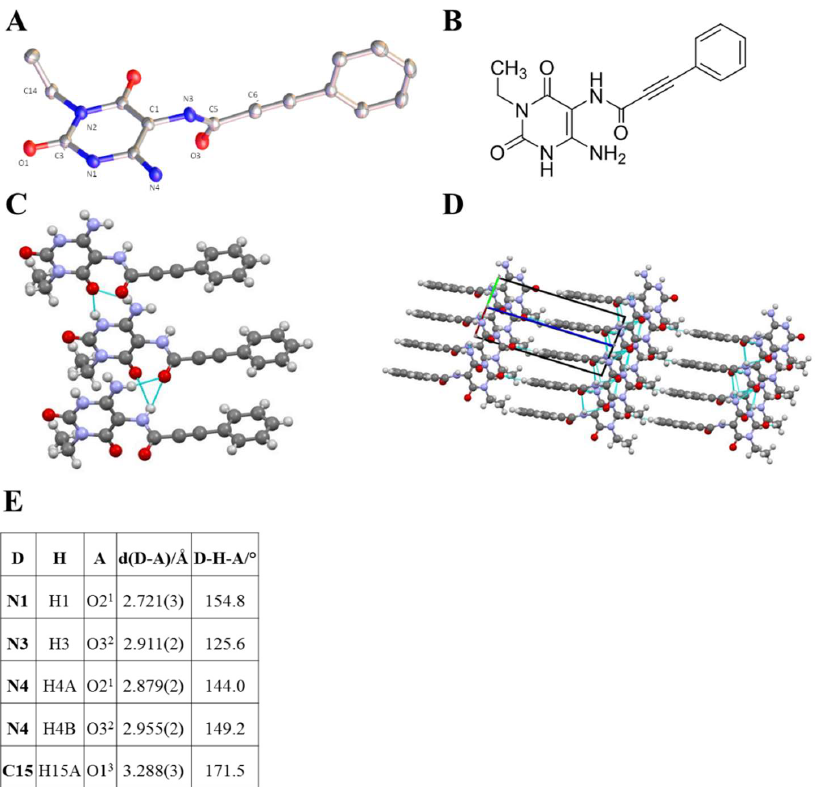
Figure 8. Results of the single X-ray crystallography of compound 8 . X-ray crystal structure ( A ) and chemical structure ( B ) of compound 8a . ( C ) Intermolecular hydrogen bond interactions in the crystal (colored in cyan). ( D ) Crystal unit cell of the P1 space group. ( E ) Distances of intermolecular interactions in the crystal structure. For color coding see Figure 7.